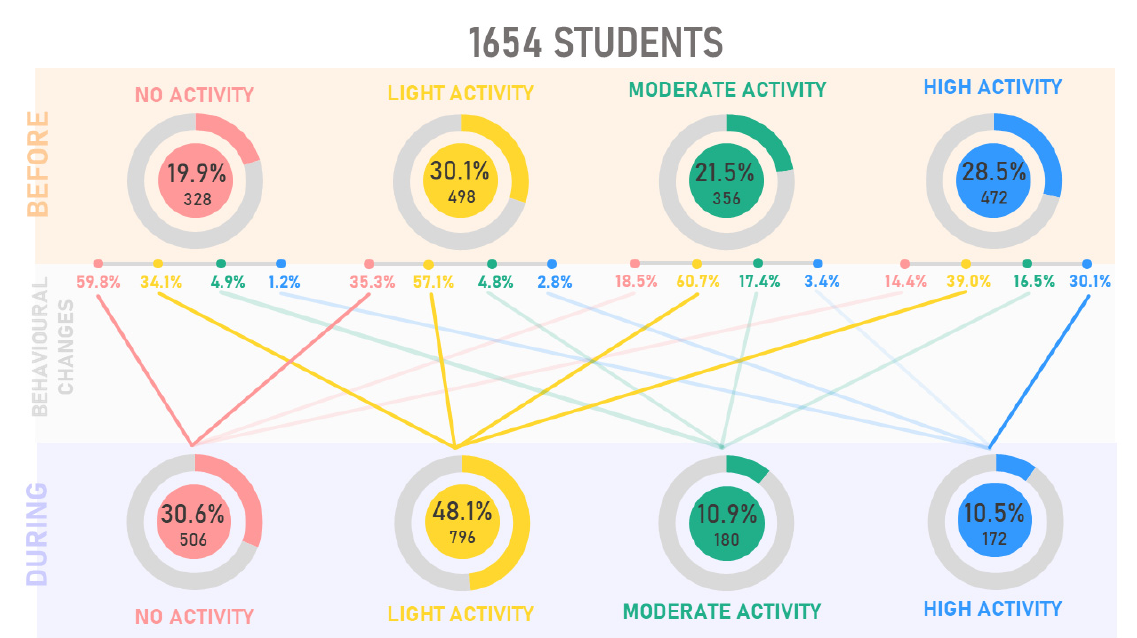
Figure 6. Physical activity changes before (March 2020) and during (March 2020/2021) one year of pandemic restrictions.